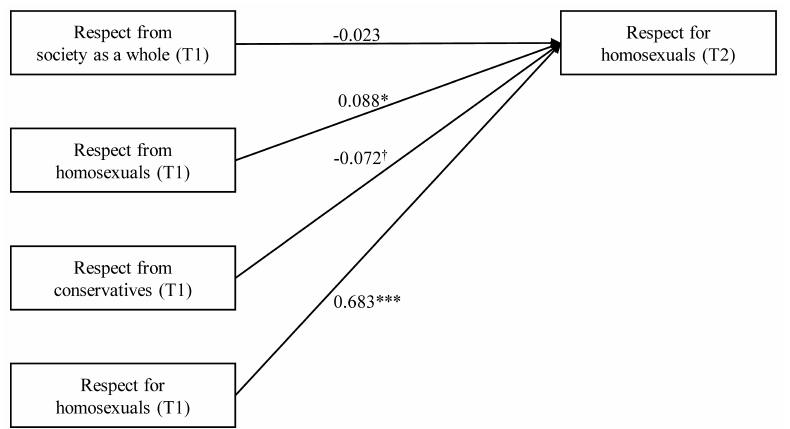
Figure 1. Antecedents of respect for homosexuals in a sample of U.S. Tea Party supporters ( N = 423). Note. For better legibility, correlations and influences of sociodemographic variables are not shown (see text). † p ≤ .10. * p ≤ .05. ** p ≤ .01. *** p ≤ .001 (all